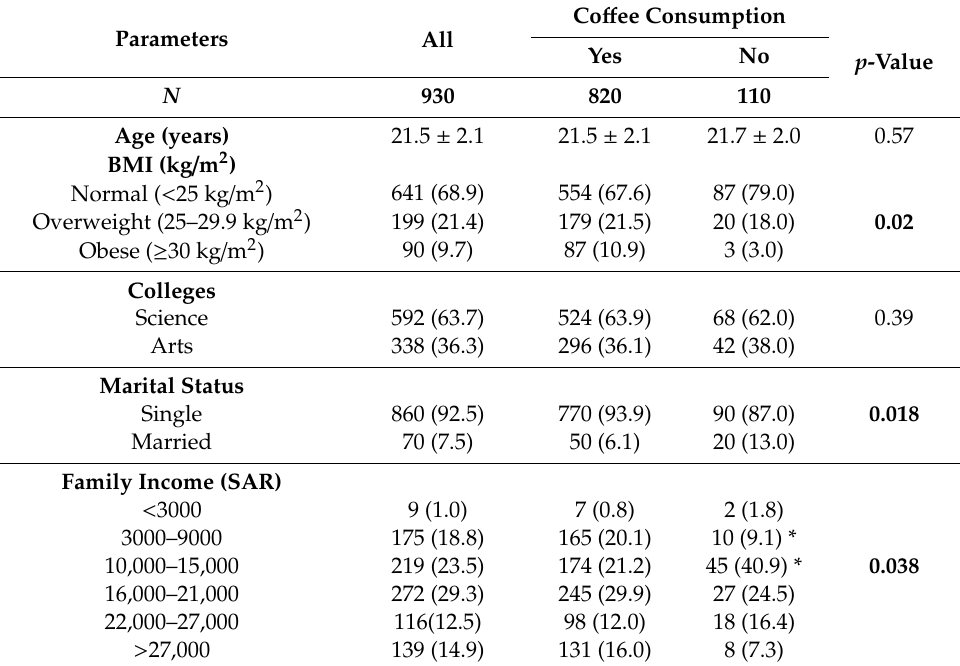
Di ff erences in demographic and anthropometric characteristics of co ff ee consumers vs.